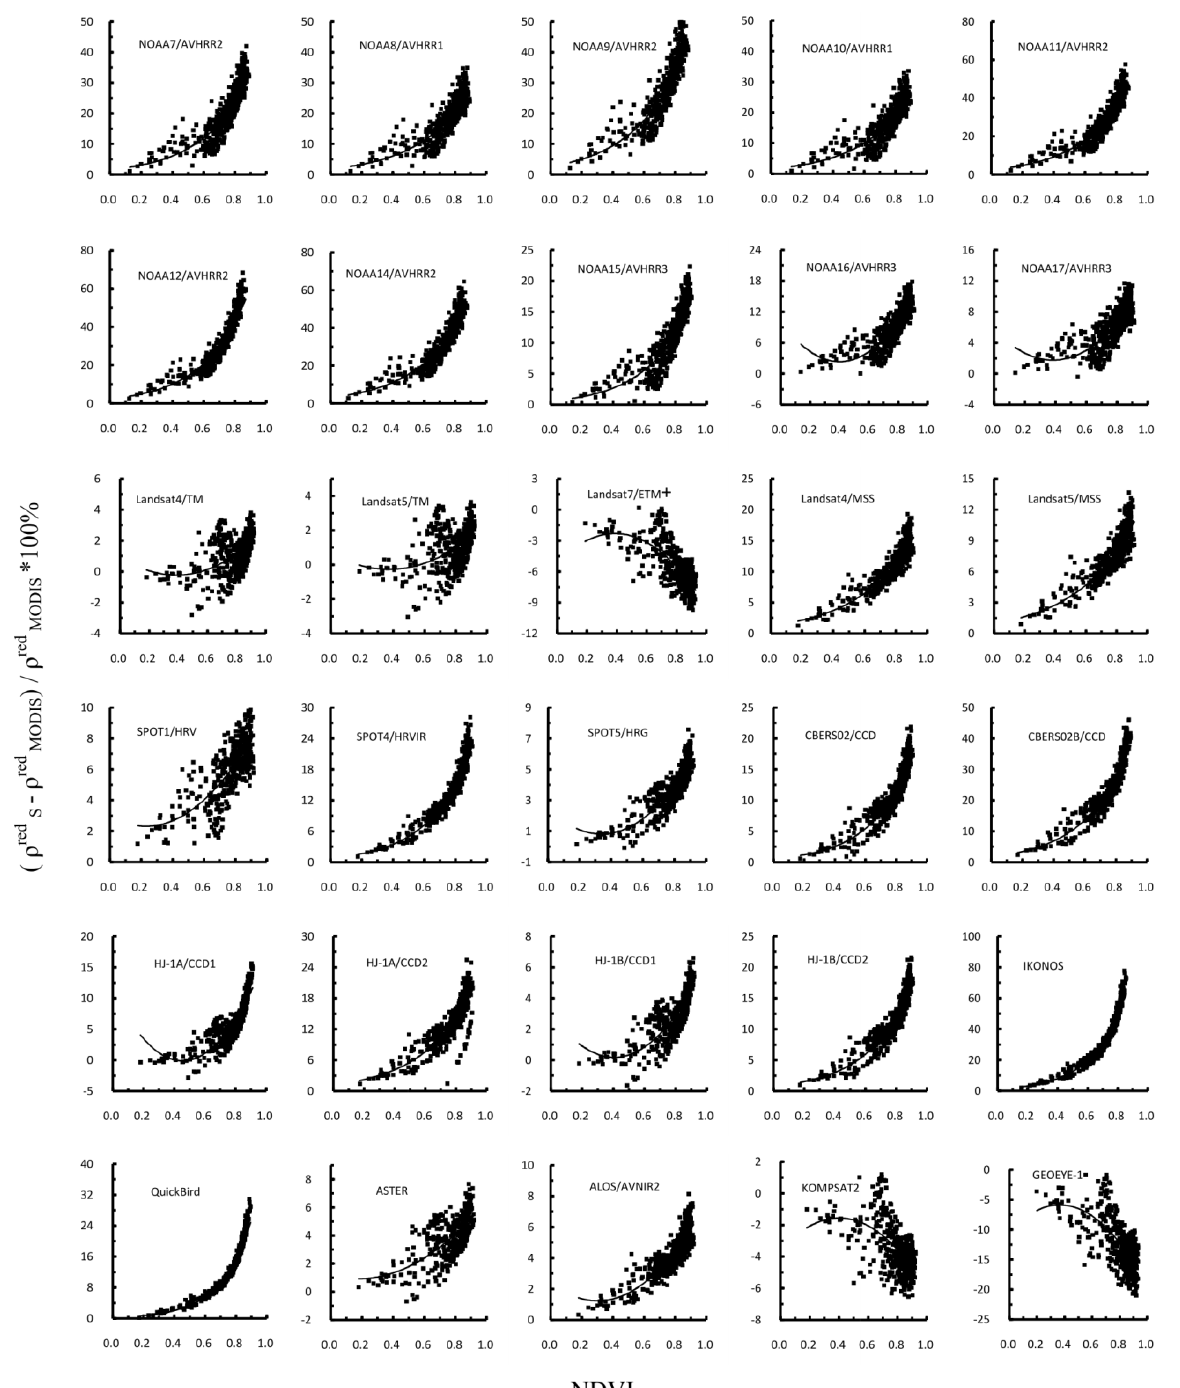
Figure 5. Relative percentage differences in the red channel reflectances with respect to Terra MODIS. All data points are plotted versus the NDVI of a particular sensor. Parameters of the fitting curves are given in Table